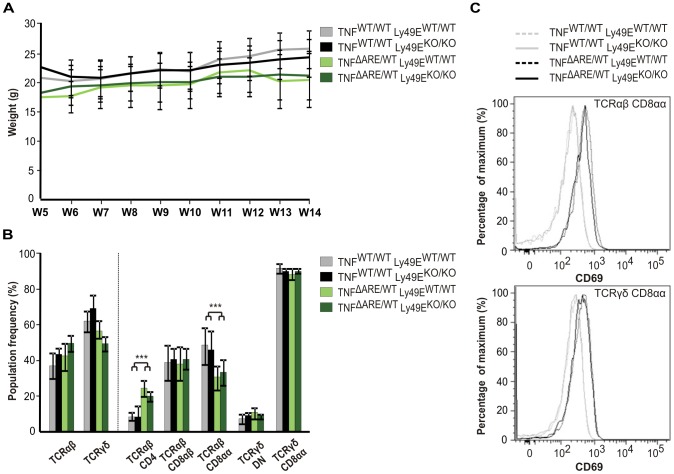
TNFΔARE-induced ileitis on an Ly49E WT versus Ly49E KO background.A) Weight progression of TNFΔARE/WT Ly49EWT/WT and TNFΔARE/WT Ly49EKO/KO mice as compared to TNFWT/WT Ly49E WT and Ly49E KO mice (mean ±SD; n = 30 (TNFΔARE/WT Ly49EWT/WT), n = 22 (TNFΔARE/WT Ly49EKO/KO), n = 31 (TNFWT/WT Ly49E WT) and n = 21 (TNFWT/WT Ly49E KO)). Weight was monitored weekly from the age of genotyping (5 weeks of age) up to 14 weeks of age. B) Small intestinal iIEL subpopulation frequencies in TNFΔARE/WT Ly49EWT/WT and TNFΔARE/WT Ly49EKO/KO mice as compared to TNFWT/WT Ly49E WT and Ly49E KO mice (mean ±SD; n = 6). TCRαβ CD4, TCRαβ CD8αβ and TCRαβ CD8αα iIEL subpopulation frequencies are shown as a percentage of the total TCRαβ iIELs. TCRγδ DN and TCRγδ CD8αα iIEL subpopulation frequencies are shown as a percentage of the total TCRγδ iIEL. C) CD69 expression on small intestinal TCRαβ CD8αα iIELs and TCRγδ CD8αα iIELs of TNFΔARE/WT Ly49EWT/WT and TNFΔARE/WT Ly49EKO/KO mice as compared to TNFWT/WT Ly49E WT and Ly49E KO mice (mean ±SD; n = 6).